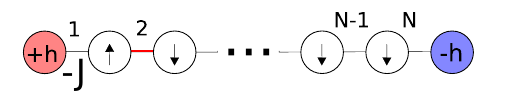
Fig. 1 Illustration of the Hamiltonian showing one of the ground states assuming that h > J and the qubits at the ends satisfy the applied fi elds. Numbers indicate domain-wall